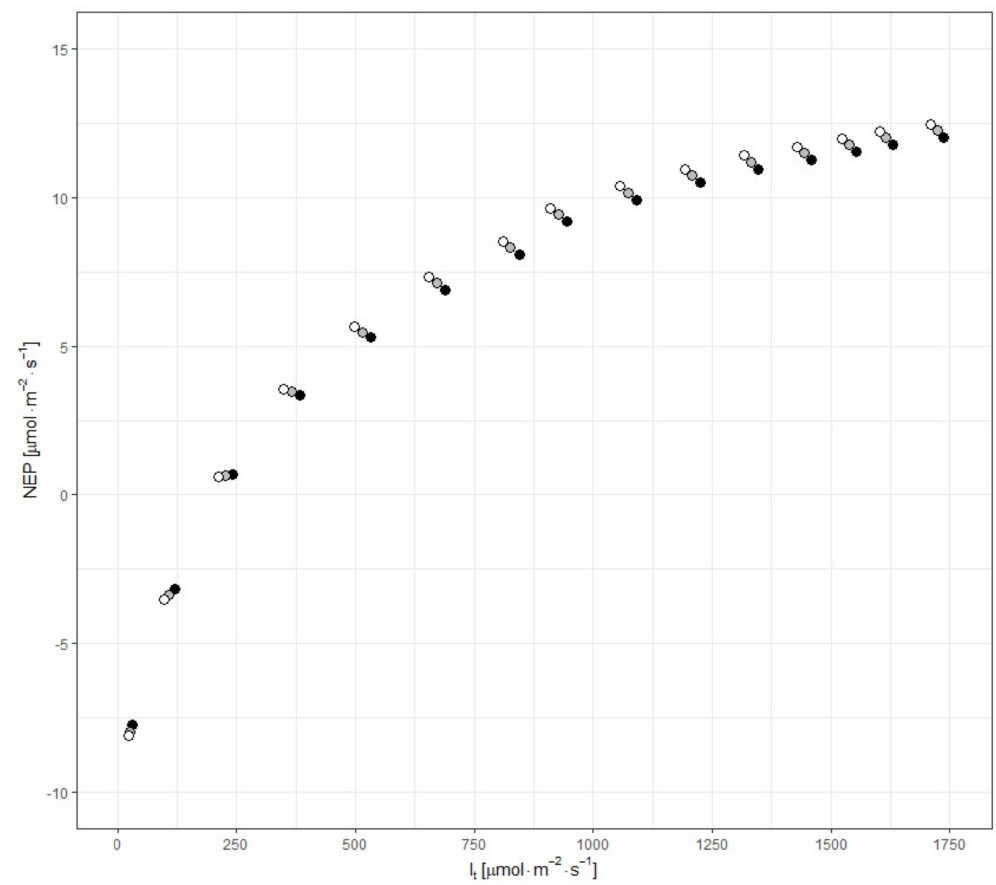
Figure 8. Net ecosystem production (NEP) vs. total photosynthetic photon flux density (I t ) of Rzecin peatland calculated for conditions on June 23rd, 2016 (DOY 175). There were three different values of AOT500 applied: 0.09 (black circle), 0.13 (grey circle), and 0.17 (white